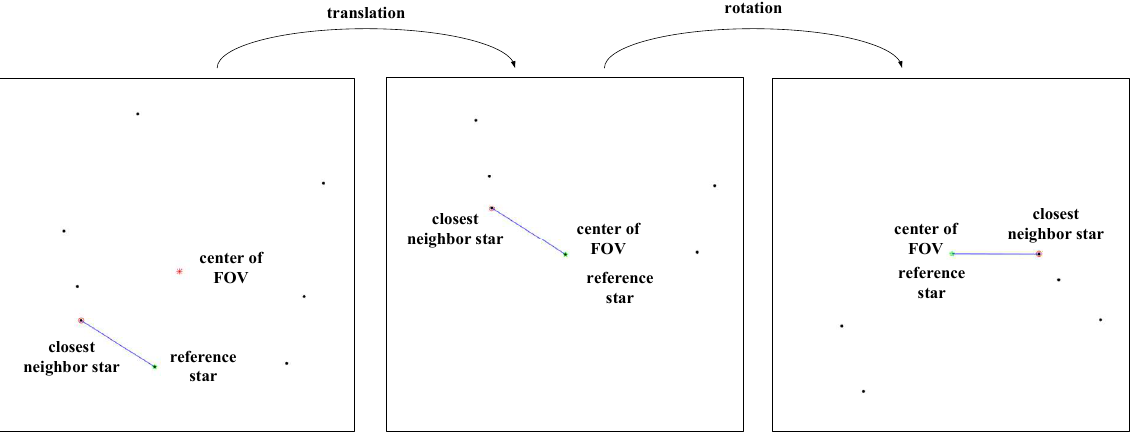
Figure 2. Registration—the captured image is translated and rotated for comparison to the